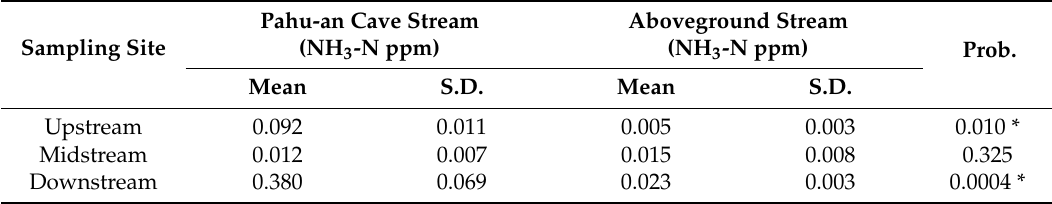
Table 4. Ammonium content (water).